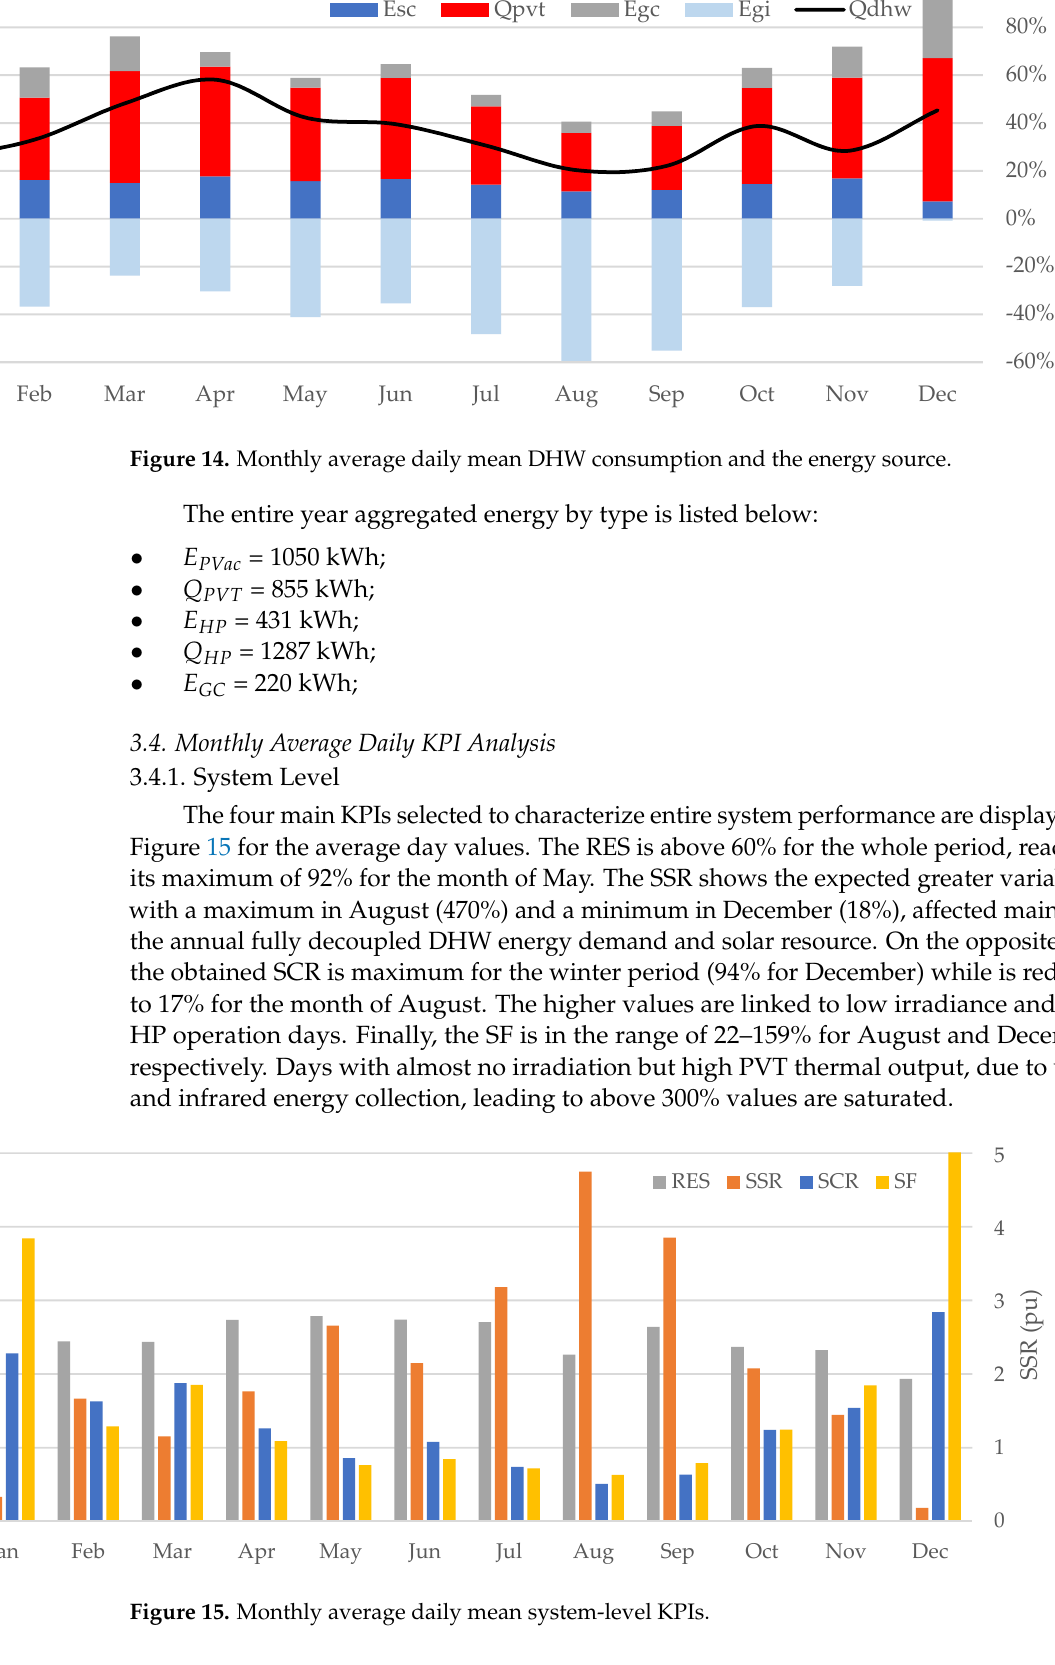
Figure 13. Monthly average daily mean energy magnitudes.